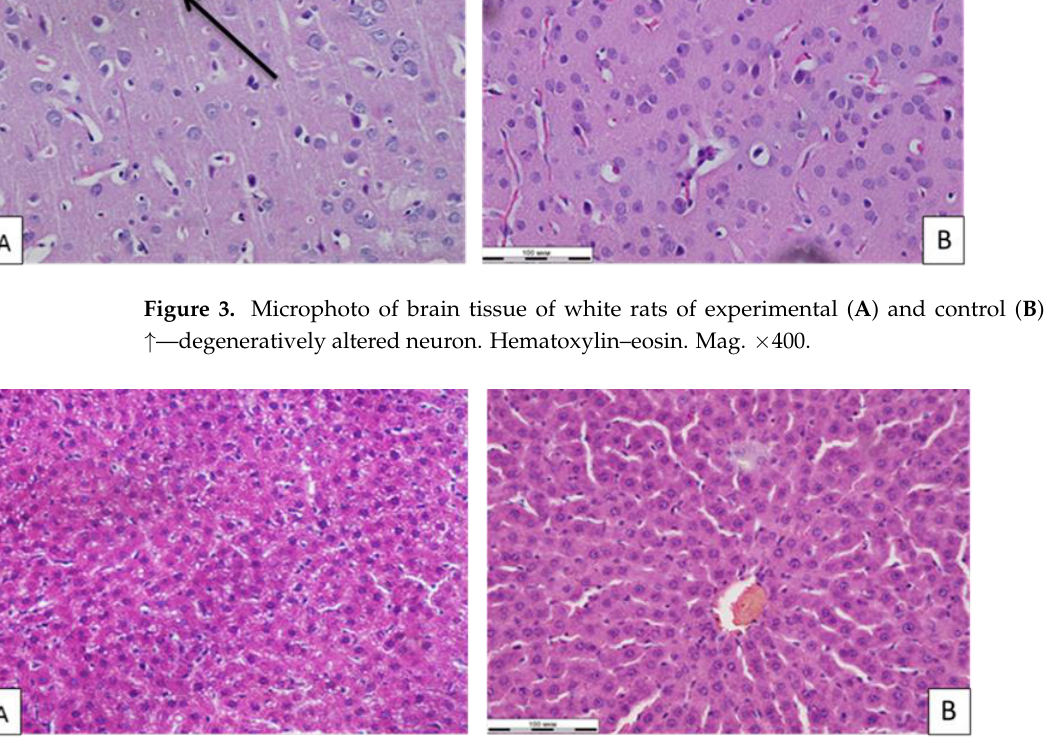
Figure 3. Microphoto of brain tissue of white rats of experimental ( A ) and control ( B ) groups. ↑ — degeneratively altered neuron. Hematoxylin – eosin. Mag. ×400.